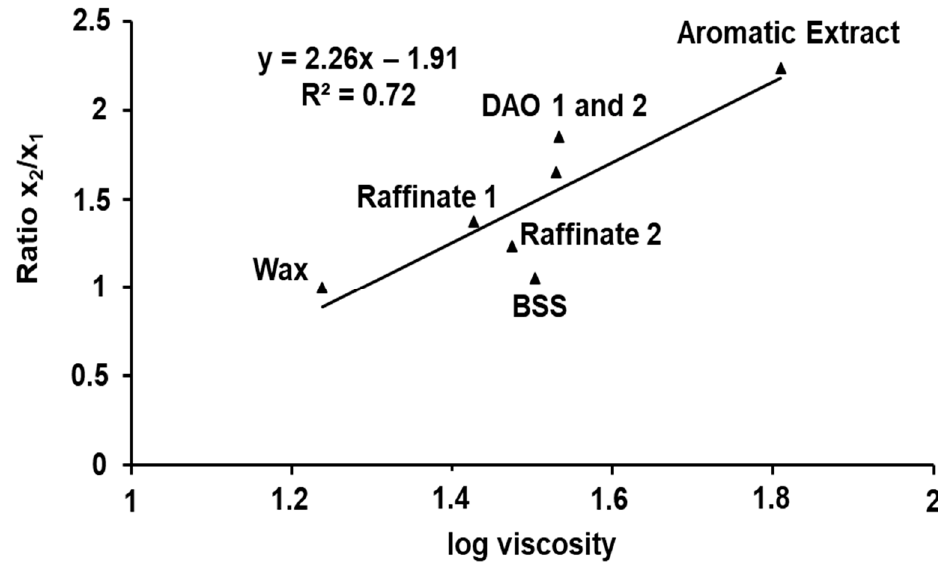
Figure 5. Ratio of x 2 / x 1 as a function of the log of viscosity.